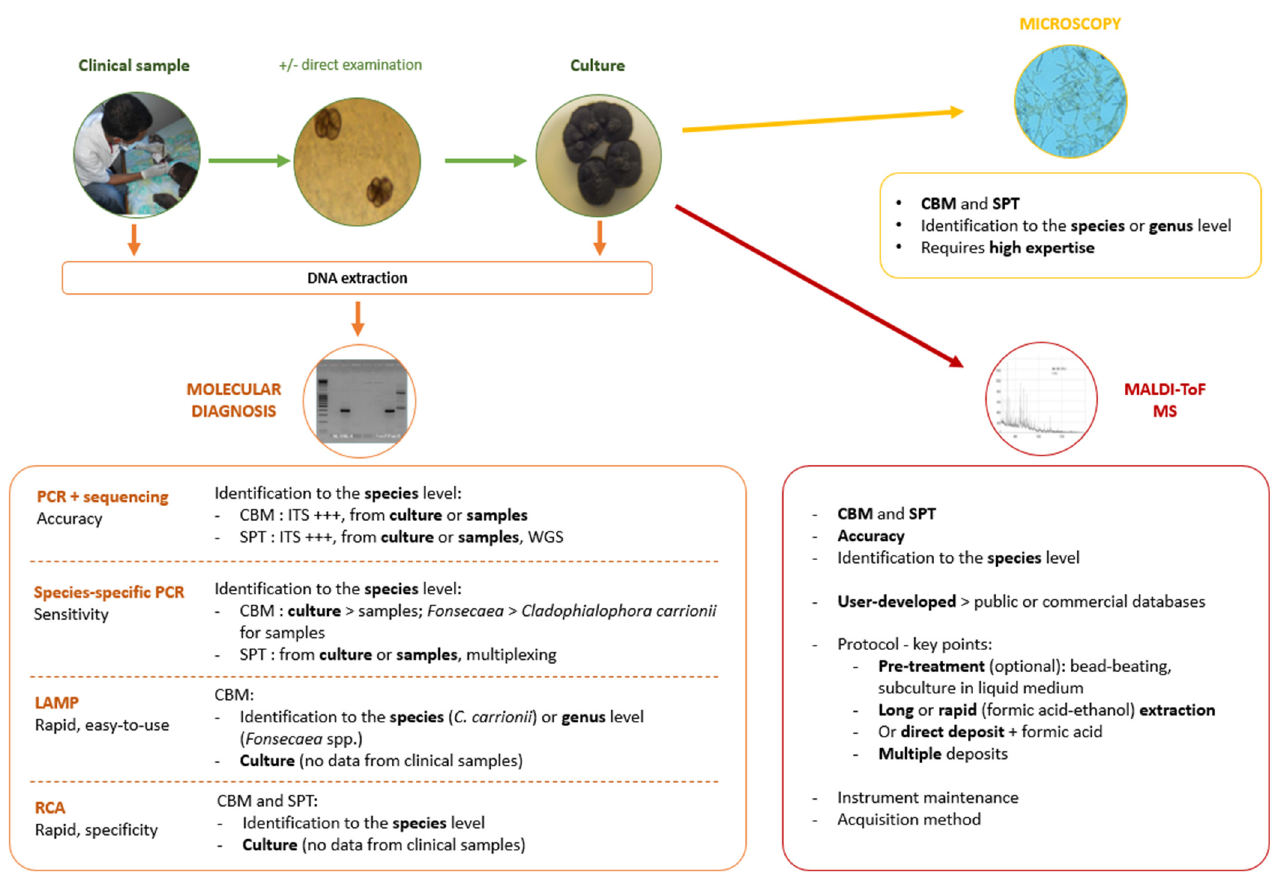
Figure 1. Diagnostic techniques for chromoblastomycosis (CBM) and sporotrichosis (SPT). ITS: internal spacer; WGS: whole genome sequencing; LAMP: loop-mediated isothermal amplification; RCA: rolling circle amplification; MALDI-ToF MS: matrix-assisted laser desorption/ionization time- of-flight mass spectrometry. Table 1. Availability of molecular diagnostic techniques of chromoblastomycosis and sporotrichosis. Fieldwork/Rural Clinics Local Laboratories Expert Laboratories